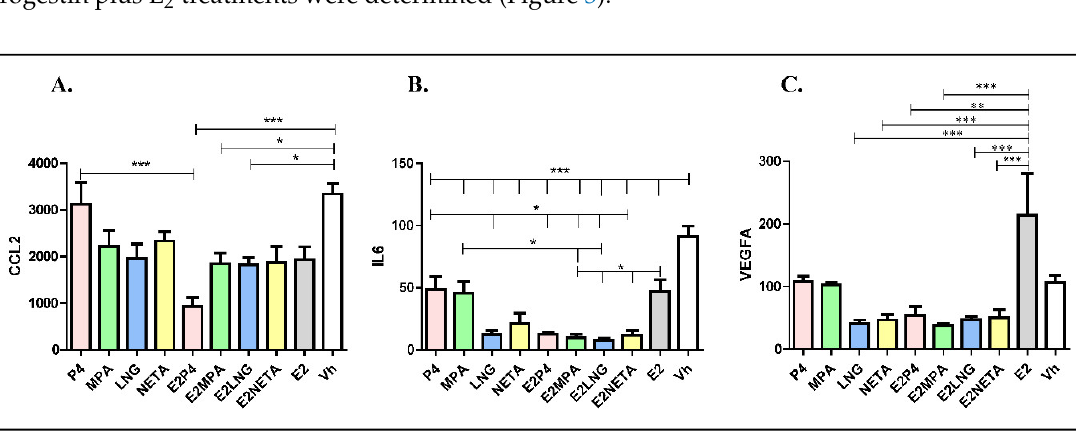
Figure 3. Concentrations of secreted CCL2, IL-6 and VEGFA in media conditioned by eSF after progestin and progestin plus E 2 treatments. ( A ) Secreted CCL2. ( B ) Secreted IL-6. ( C ) Secreted VEGFA. In all cases, the figure shows the “amount” of secreted protein for each progestin and each progestin, plus E 2 adjusted by cell number and total media. Pink-colored bars: progesterone (P 4 ); green-colored bars: medroxyprogesterone acetate (MPA); blue-colored bars: levonorgestrel (LNG); yellow-colored bars: norethindrone acetate (NETA); gray-colored bars: E 2 alone; white bars: vehicle. Error bars indicated SD; * p < 0.05, ** p < 0.01, *** p < 0.001.